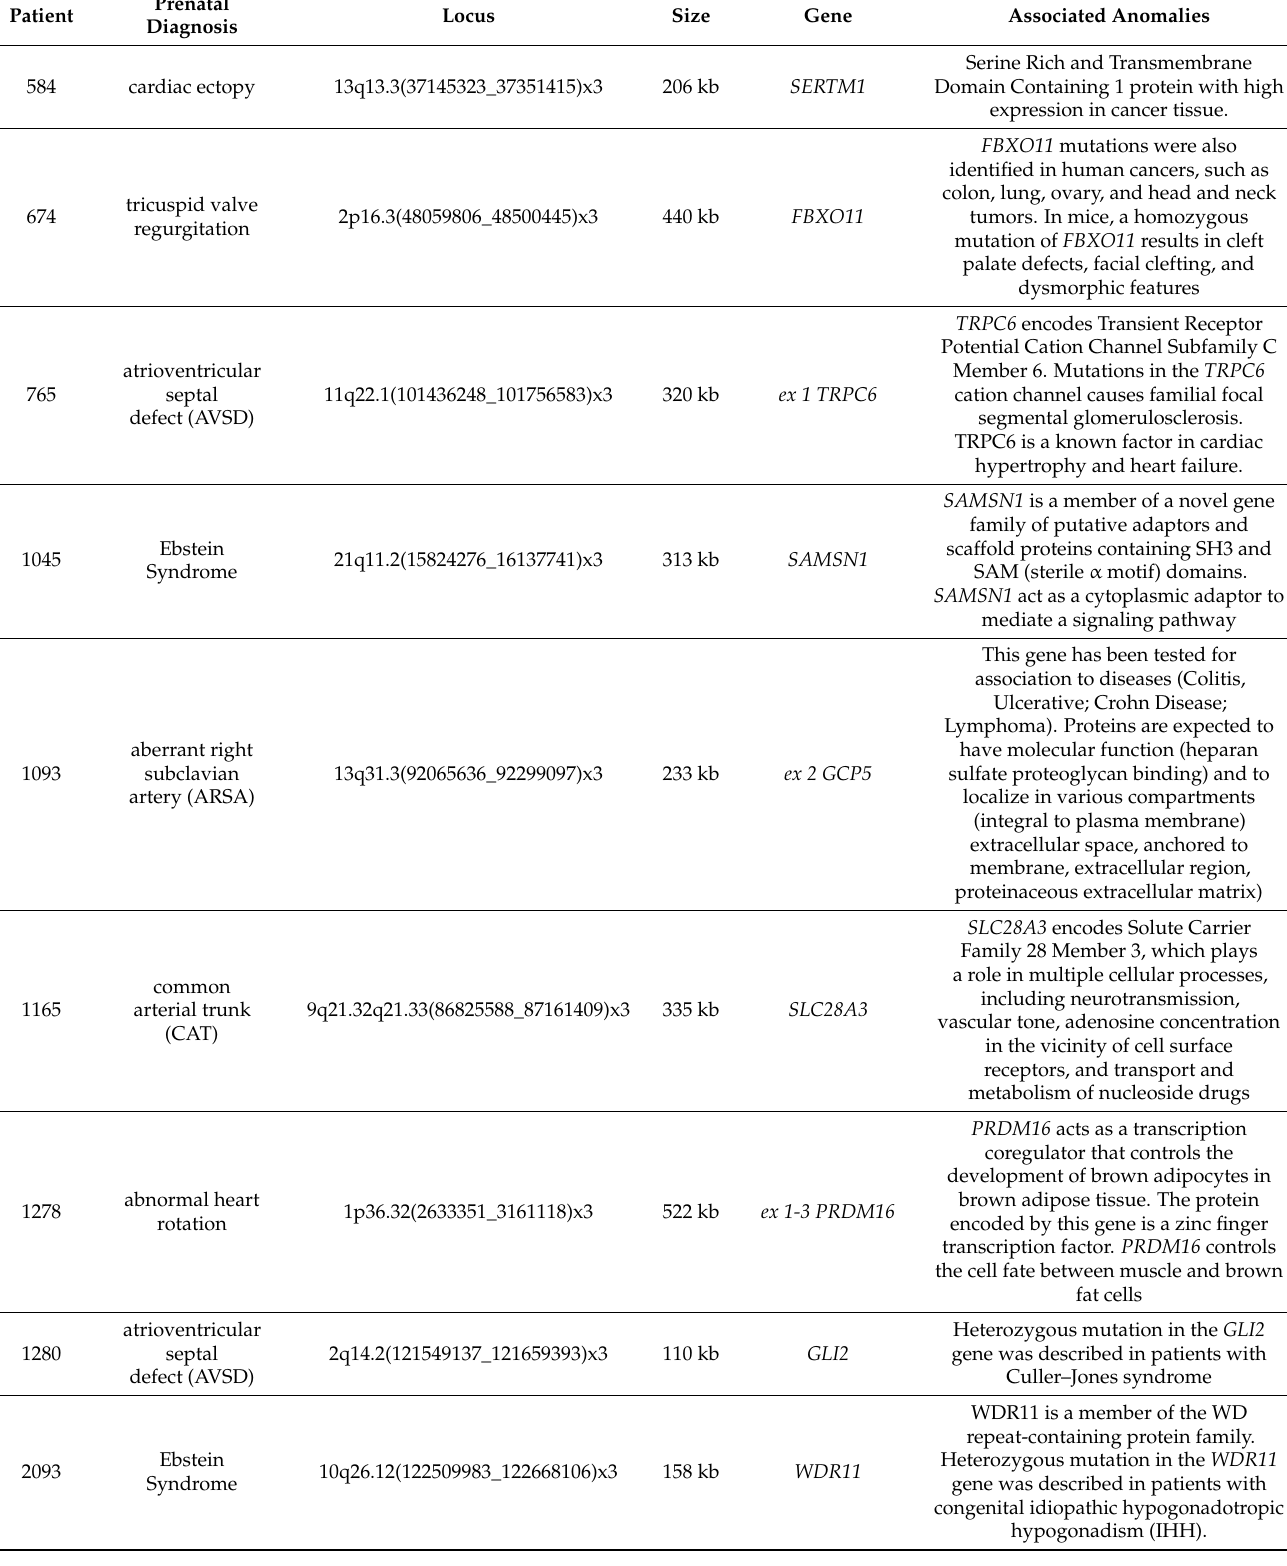
Table 4. VOUS structural